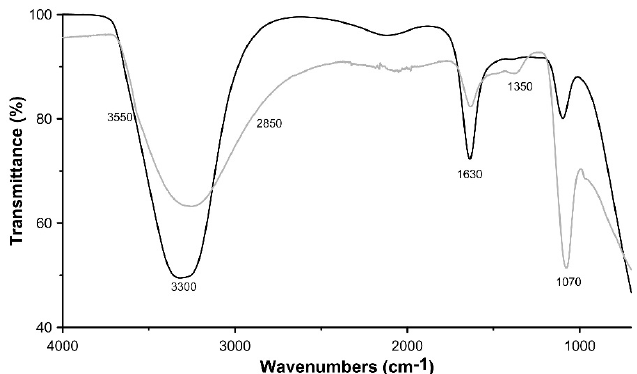
Figure 3. FTIR spectra of LDH 3CuAl·SO 4 at pH 8 (black line) and pH 10 (grey line).